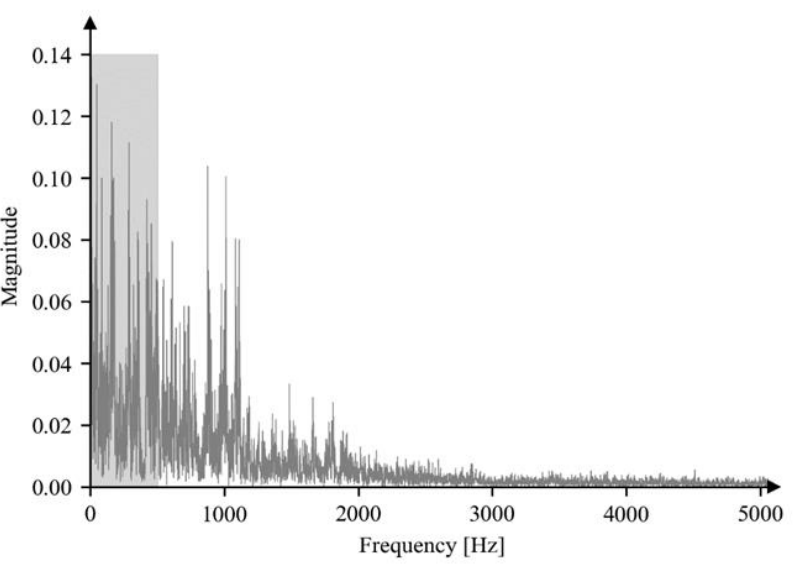
Figure 5. Frequencies of the welding fume extraction without welding. The grey marked area represents the lower cut-off frequencies of the first filter stage.